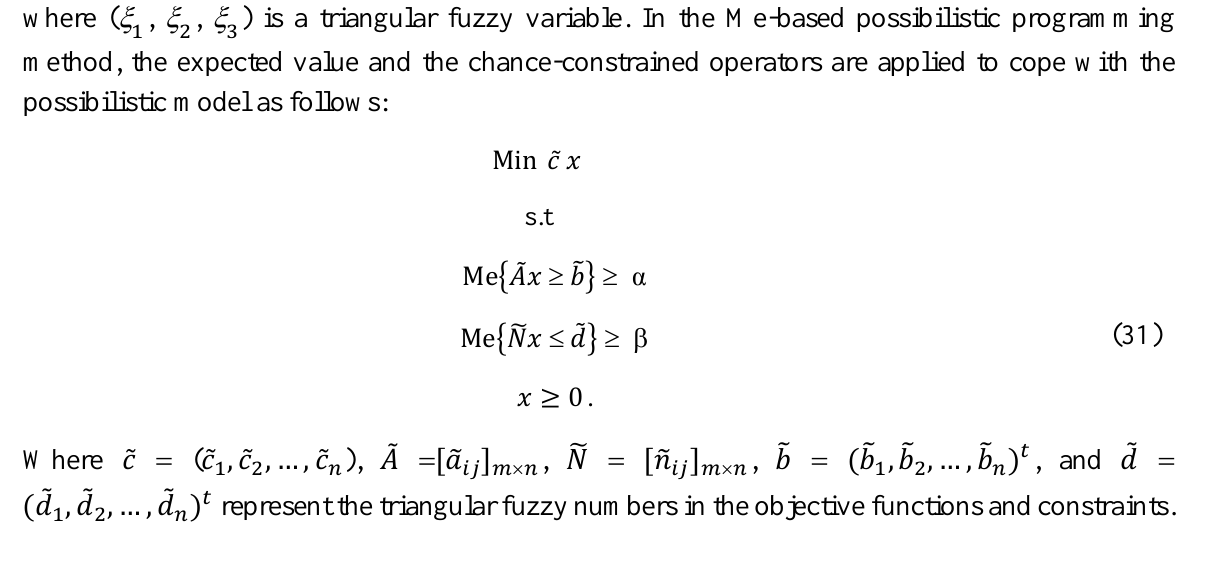
Imperialist Competitive Algorithm (ICA), and Self-adaptive